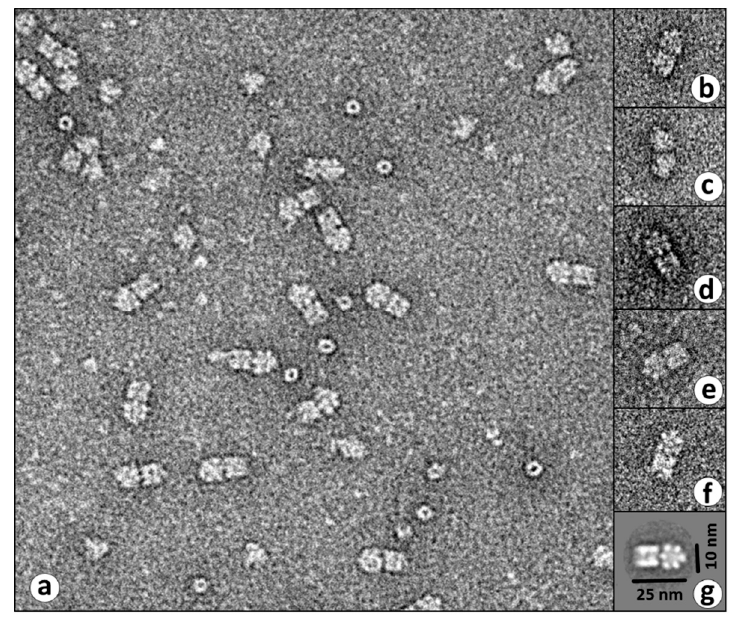
Figure 1. Electron microscopical images of hemolymph proteins of various springtails. The “single droplet negative staining“ technique and 2% (v/v) aqueous uranyl formate was applied for the preparation of the sample. ( a ) Overview of the hemolymph proteins of Orchesella villosa . A huge amount of the 2 × 6-meric protein is present in the hemolymph. Inserts show 2 × 6-meric proteins found in the hemolymph from Isotoma viridis ( b ), Folsomia candida ( c ), Coecobrya tenebricosa ( d ), Orchesella cincta ( e ), and Sinella curviseta ( f ) [29]. ( g ) Superposition of 13 images of Sinella curviseta hemocyanin for gaining a better contrast.